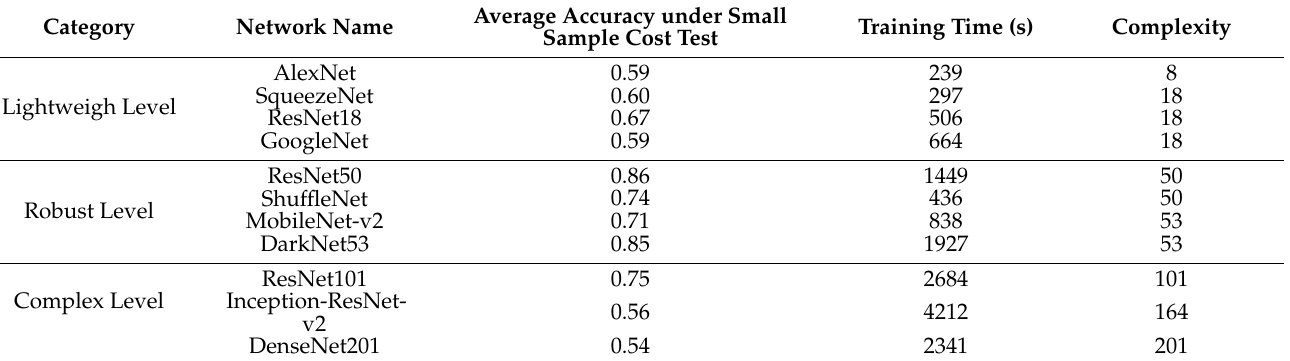
Table 3. Test of feature extraction network performance.